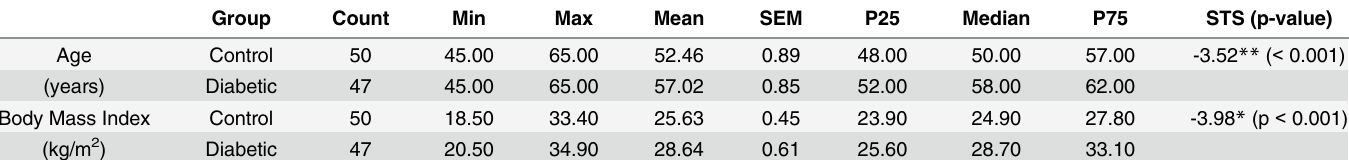
Table 2. Descriptive statistics for quantitative sociodemographic data and comparison according to Type of